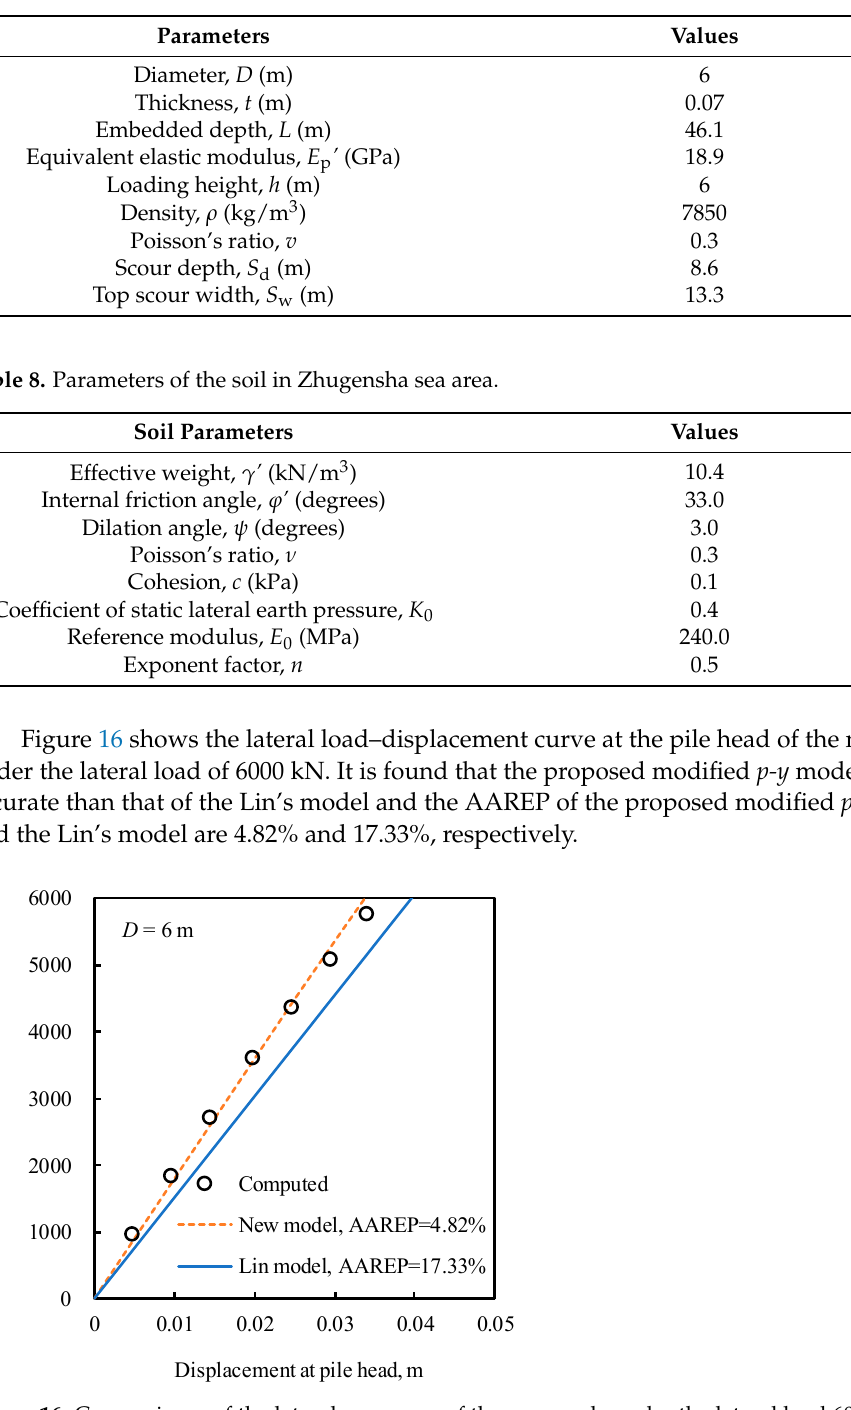
Figure 16. Comparisons of the lateral responses of the monopole under the lateral load 6000 kN.